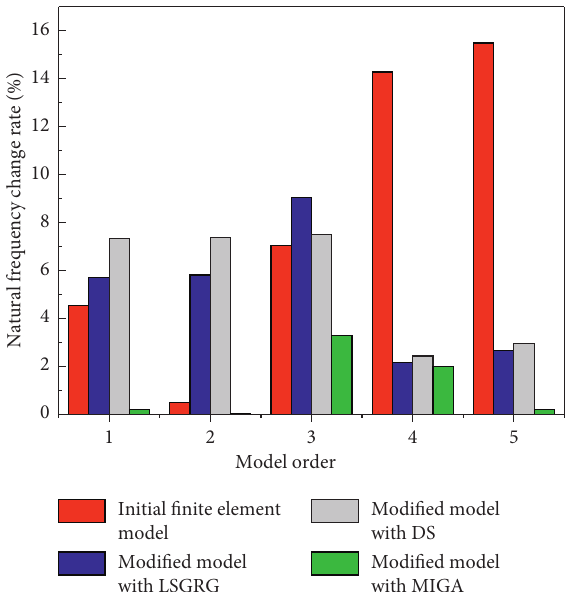
Figure 10: Comparison of natural frequency difference before and after model modification.